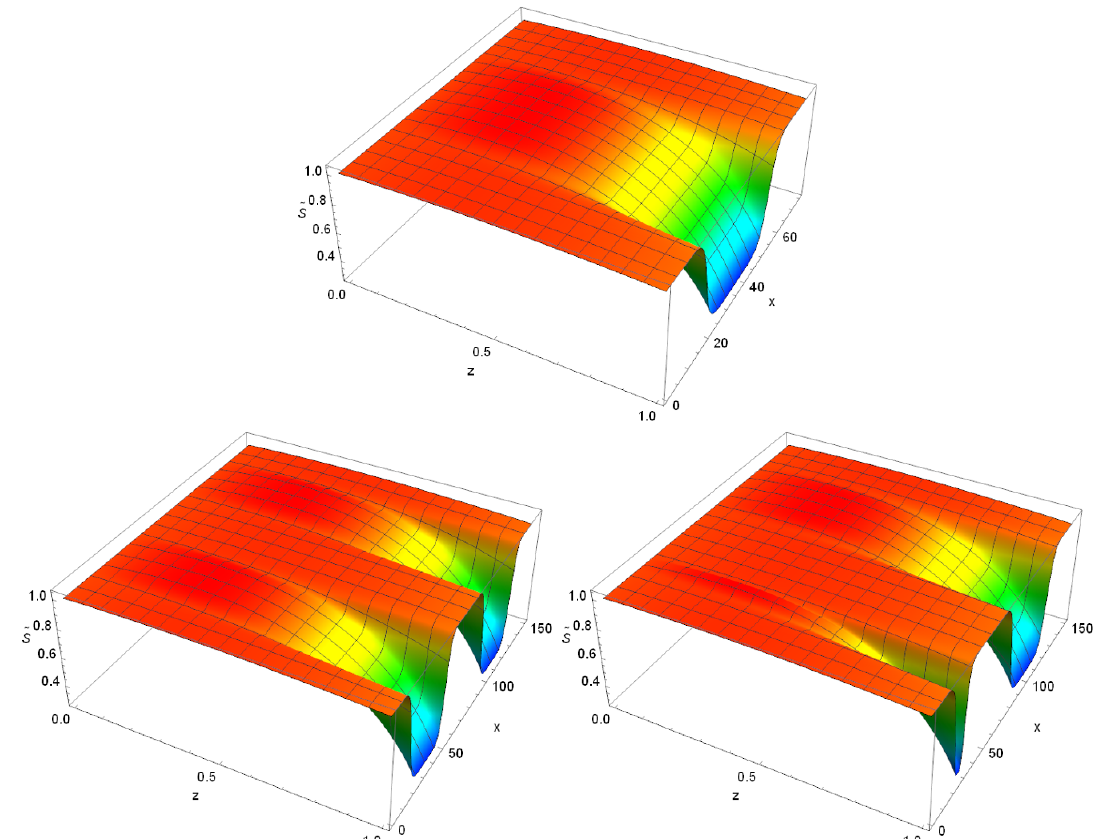
Figure 5 . Preparing the initial conditions for ~ S ( z; x ): the original static (cid:12)nal state from [16] at the top, the doubled con(cid:12)guration (bottom left) and the subsequent deformation by the nonlinear g ( x ) function (4.3) (bottom right).